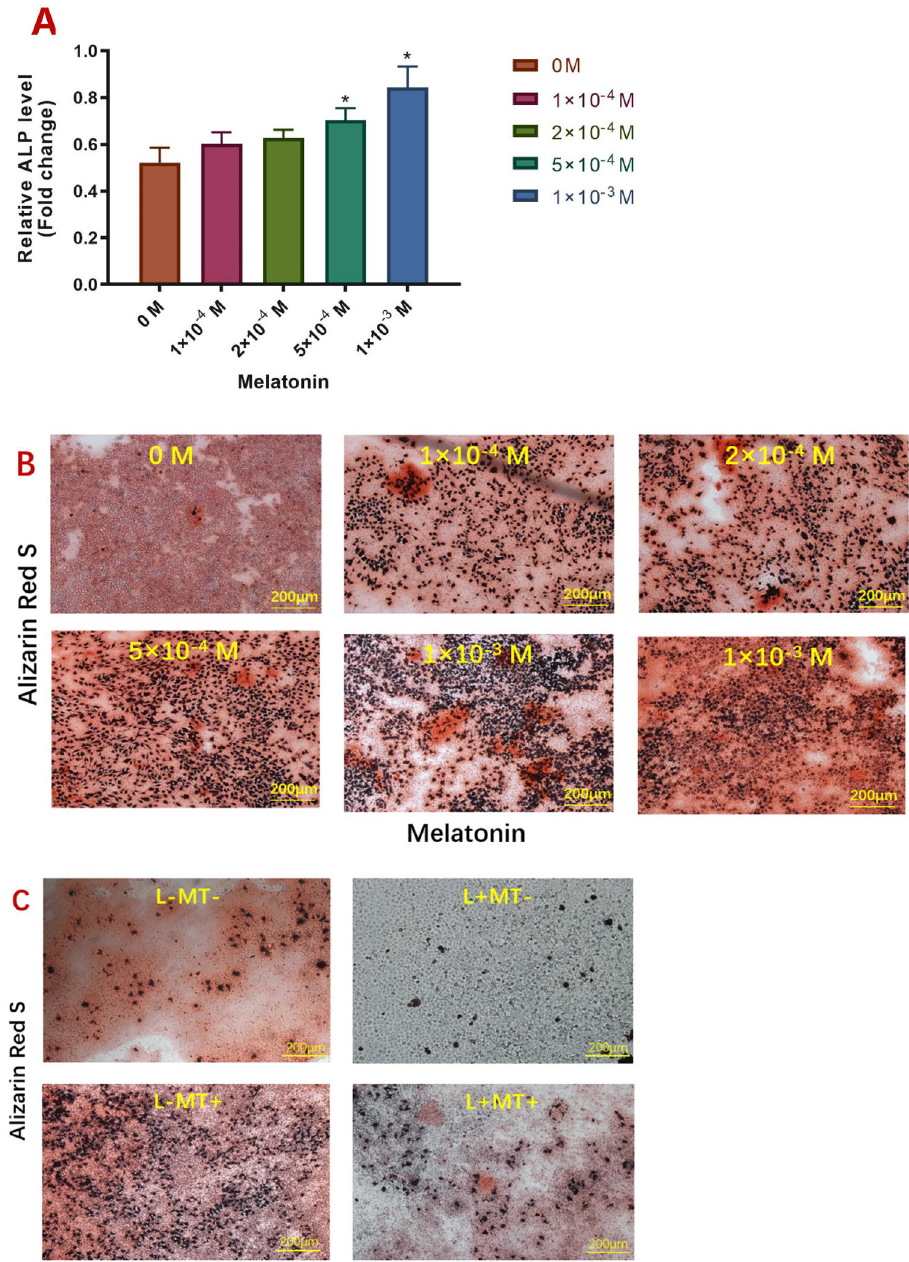
Figure 4. Effect of melatonin on ALCs’ mineralization. ( A ) ALP activity in ALCs under MT treatments (0, 1 × 10 –4 , 2 × 10 –4 , 5 × 10 –4 , 1 × 10 −3 M) was determined on day 7. Each value was presented as mean ± SD for triplicate experiments. (*p < 0.05, **P < 0.001, compared to control). The magnification is 200 μm. ( B ) Effect of melatonin on the formation of the mineralized nodule in ALCs. Cells were treated with various concentrations of MT (0, 1 × 10 –4 , 2 × 10 –4 , 5 × 10 –4 , 1 × 10 −3 M) for 28 days. ( C ) Effect of melatonin and Luzindole on the formation of mineralized nodules of ALCs. Cells were incubated with the conditioned medium ((L-MT−), (L + MT−), (L-MT+), (L + MT+)) for 28